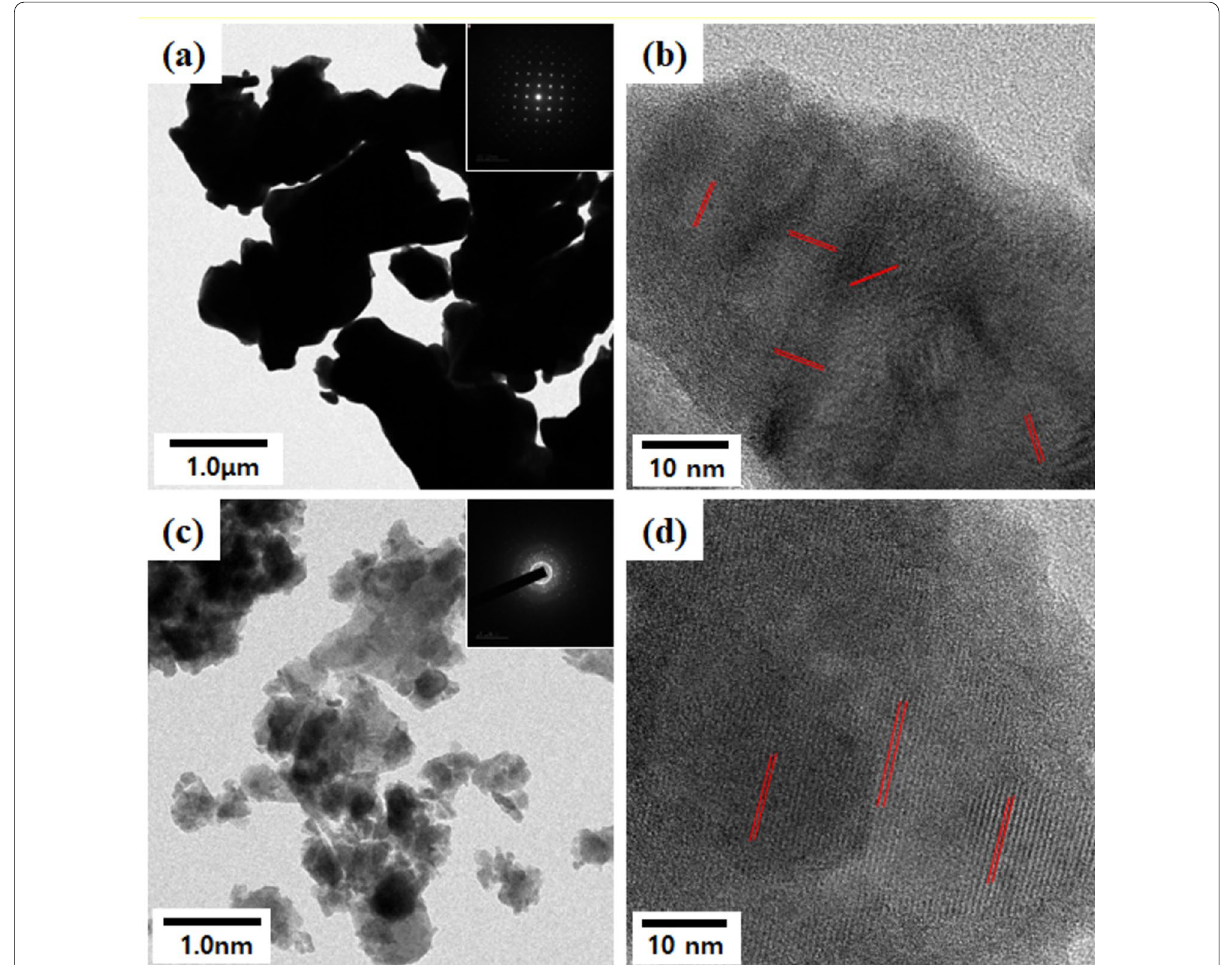
Fig. 3 TEM images of BLT powder after and before treatment by high-energy ball milling; a and b Micro-size and c and d Nano-sized